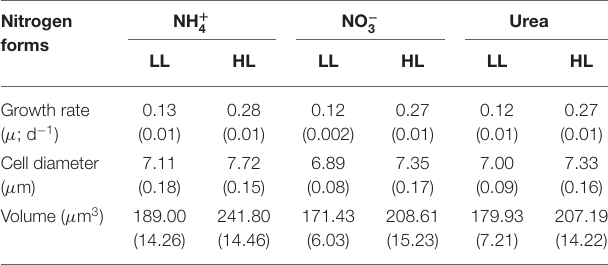
TABLE 1 | Growth rates, cell diameter and volume of C. gelidus acclimated to NH +